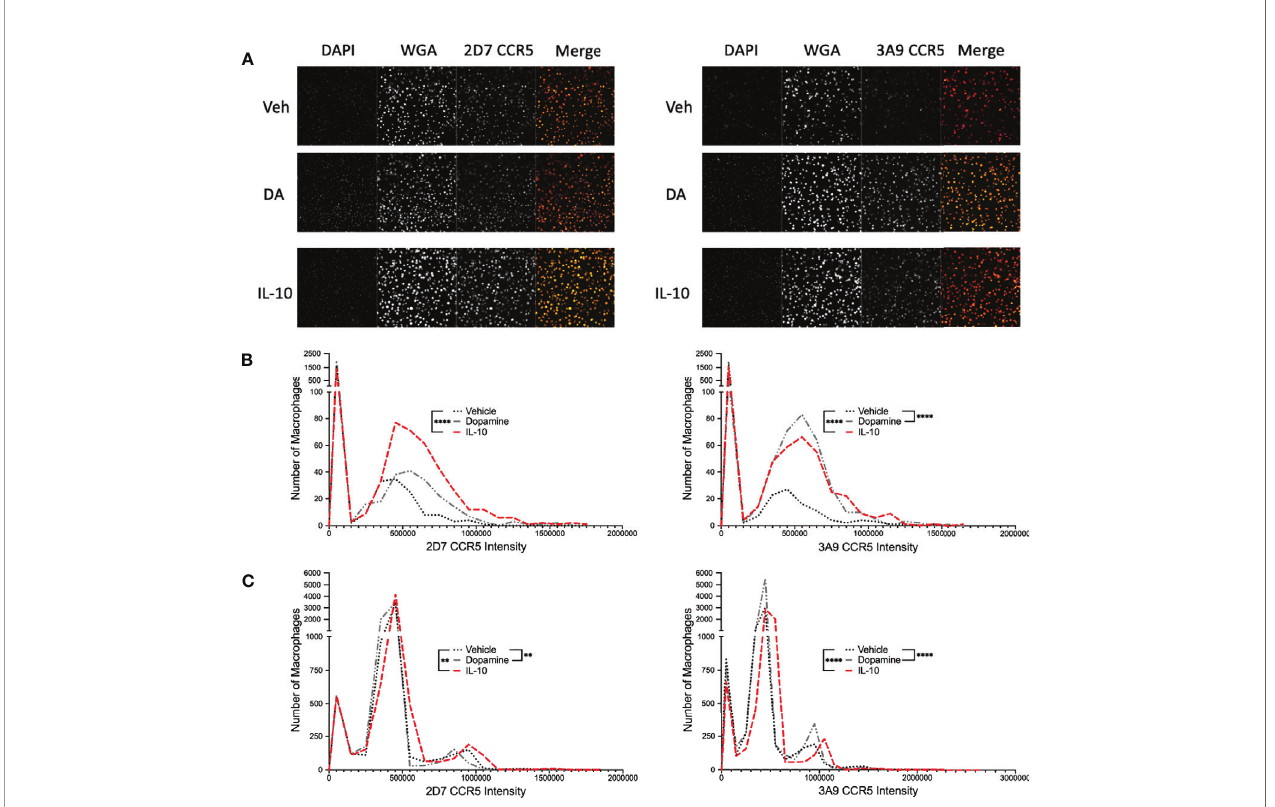
FIGURE 4 | Dopamine increases the proportion of hMDM with N-Terminal CCR5. (A) Representative images of immunocytochemical staining of hMDM with DAPI (blue), wheat germ agglutinin (WGA) (far red) and ECL2 or NT CCR5 (red). Images were acquired on the Cell Insight CX7 automated 7-channel confocal microscope, imaging ten fi elds per well using a 10x objective in a 96 well plate. CX7 data from two donors were then used to generate a frequency distribution, segregating the data from each cell into bins based on intensity, with a bin size of 100,000, and graphed as a histogram, representing the number of cells contained in each bin from each experimental condition (B) IL-10 signi fi cantly increased the population of cells with higher levels of both 2D7 and 3A9 CCR5, while dopamine only increased the number of cells with higher levels of 3A9 CCR5 (IL-10, 2D7, ****p < 0.0001, Chi-square = 114.6, df = 1, z = 10.71, 3A9, ****p < 0.0001, Chi-square = 128.5, df = 1, z = 11.34; Dopamine, 3A9, ****p < 0.0001, Chi-square = 373.1, df = 1, z = 19.31). (C) IL-10 signi fi cantly increased the population of cells with higher levels of both 2D7 and 3A9 CCR5, while surprisingly dopamine also increased the number of cells with high levels of 2D7 and 3A9 CCR5 (IL-10, 2D7, **p < 0.01, Chi-square = 9.128, df = 1, z = 3.021, 3A9, ****p < 0.0001, Chi-square = 49.83, df = 1, z = 7.059; Dopamine, 2D7, **p < 0.01, Chi-square = 8.535, df = 1, z = 2.921, 3A9, ****p < 0.0001, Chi-square = 108.6, df = 1, z =